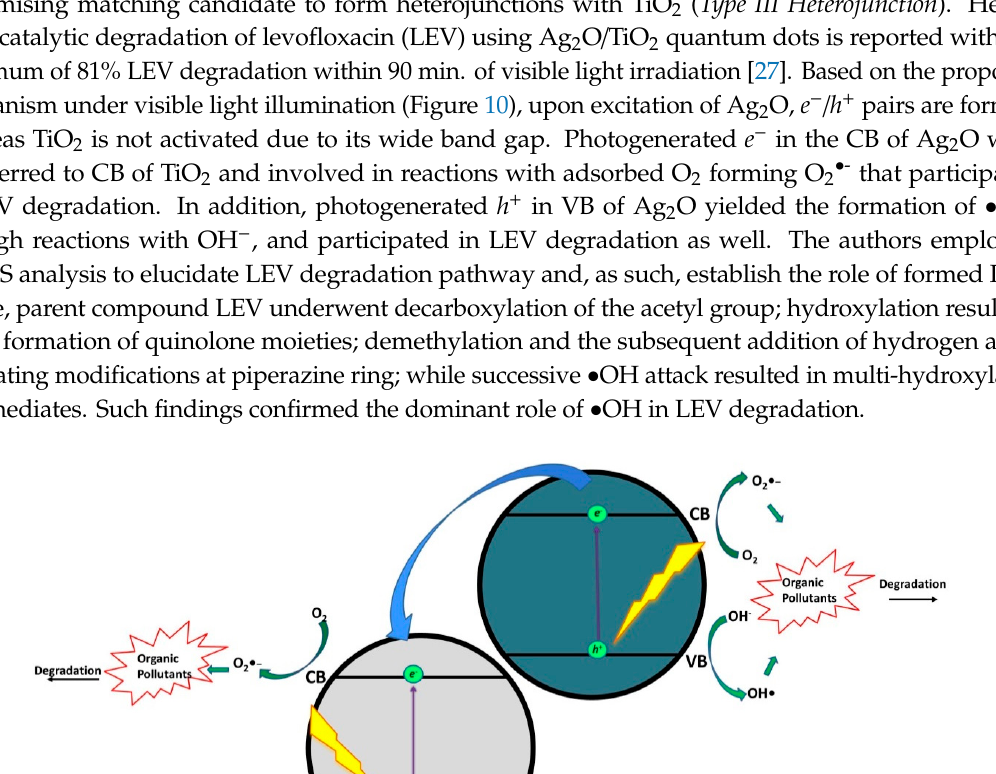
Figure 9. Photocatalytic reaction mechanism of TiO 2 − X /Ag 3 PO 4 under visible light irradiation.